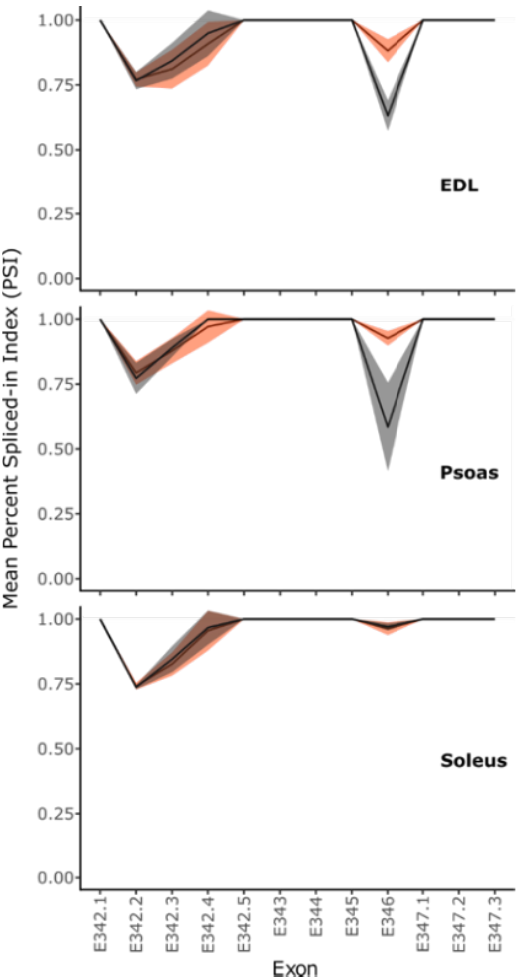
Figure 4. Expression of MEx5 (exon 346) is upregulated in fast mdm muscles (two-way ANOVA, p < 0.0001). Mean PSI values calculated for MEx1-6 encoding exons are shown. PSI = 0—complete exclusion and PSI = 1–100% inclusion of the exon/exon segment into the expressed transcript pool. The shaded area shows the standard deviation of mean PSI values. Exon labels are suffixed with a period followed by a number if the region was split into separate segments based on the variable distribution of reads in the alignments.